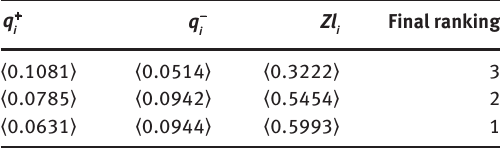
Table 5: The Separation of each Candidate from the CPIS and